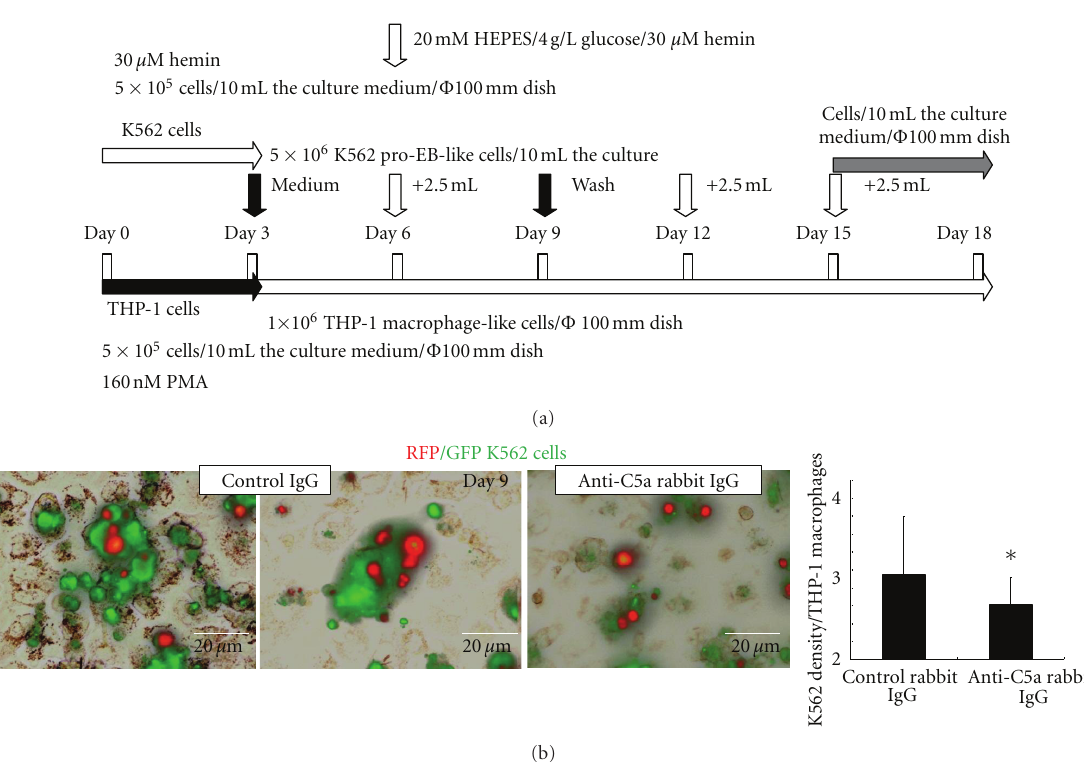
Figure 5: Contribution of the RP S19 oligomers to the K562-THP-1 cell interaction (a) Time schedule for the K562 cell that were cocultured with the THP-1 cells. (b) K562 cells expressing RFP-Nucleus/EGFP-ANXA3 were cultured for 9 days after the haemin induction and were examined under fluorescence microscopy. The microscopic images (4 pairs) were used to count the number of K562 cells on each THP-1 macrophage-like cell using the Image-J software ( n = 3). P values of less than 0.05 were considered statistically significant ( ∗ P < 0 .